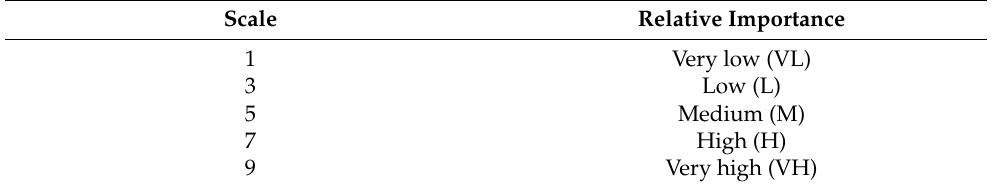
Table 2. Pair-wise comparison scale for AHP